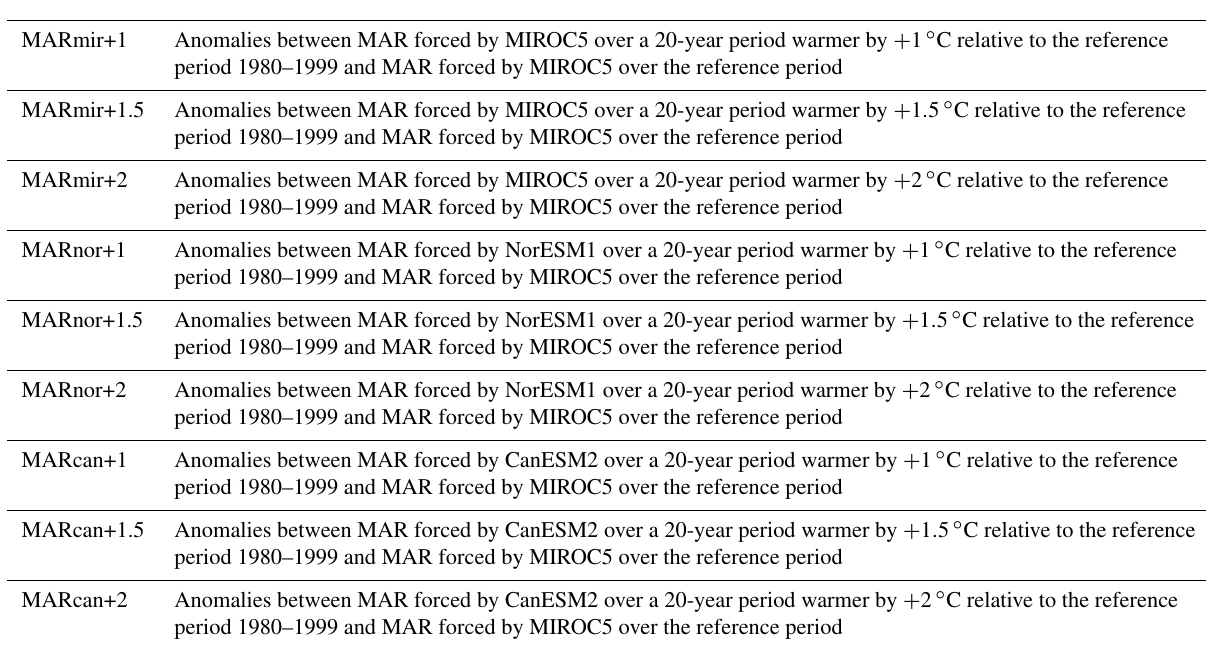
Table A2. Abbreviation description of GCM sensitivity experiments.